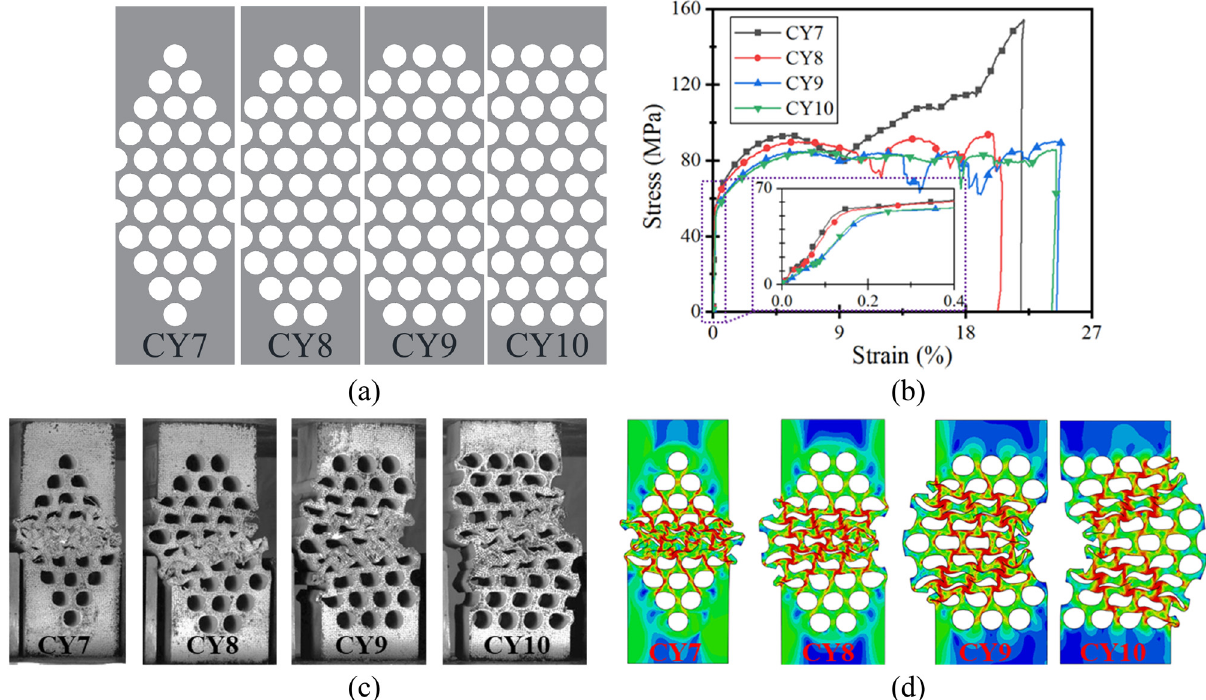
Figure 10: The e ff ect of hole arrangement shape at specimen end: ( a ) hole arrangement, ( b ) stress – strain curves, ( c ) failure mode in test, and ( d ) failure mode in